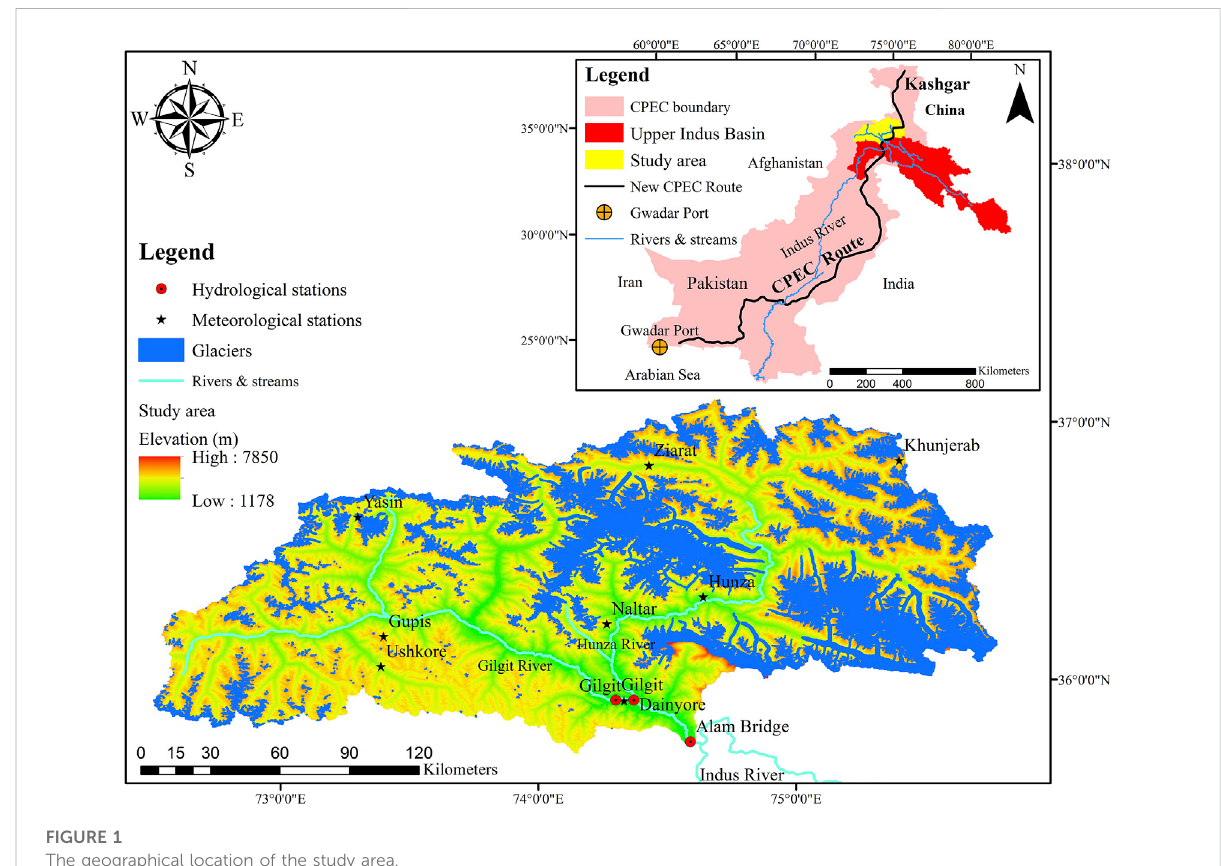
FIGURE 1 The geographical location of the study